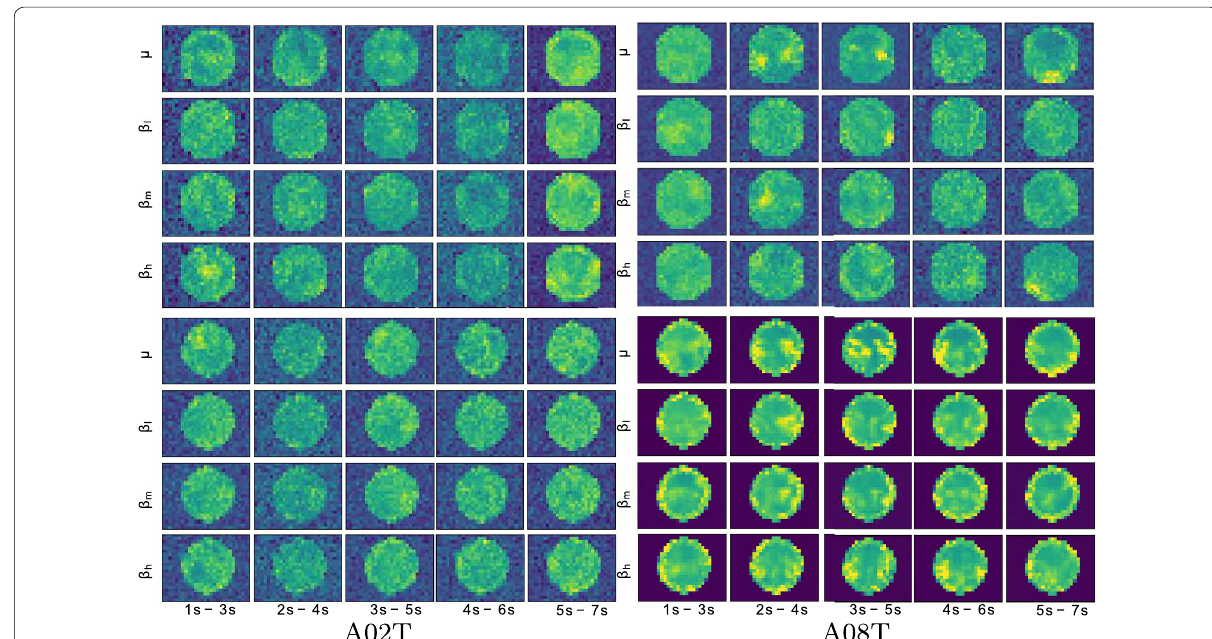
Fig. 3 Reconstructed topographic maps for the bi‑class experiment D including all bandwidths across the time domain in the best (A08T) and the worst (A02T) subjects, left and right column,